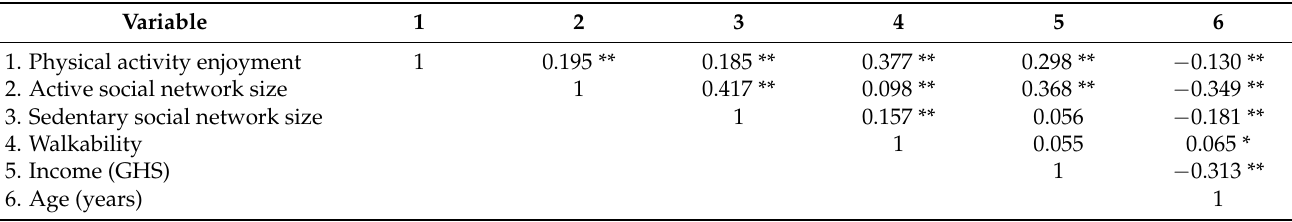
Table 2. Pearson’s correlations between active social network size, sedentary social network size, PA enjoyment, walkability, and the ultimate confounders (n =